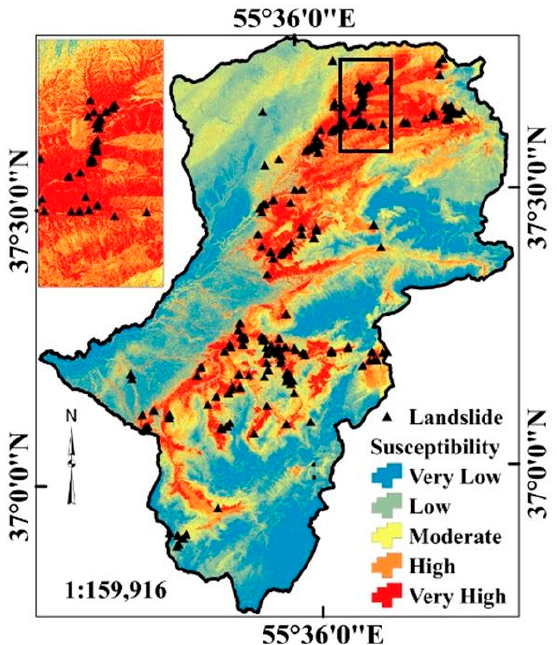
Remote Sens. 2020 , 12 , x FOR PEER REVIEW Figure 5. Landslide susceptibility map based on the RF model. Figure 5. Landslide susceptibility map based on the RF model.